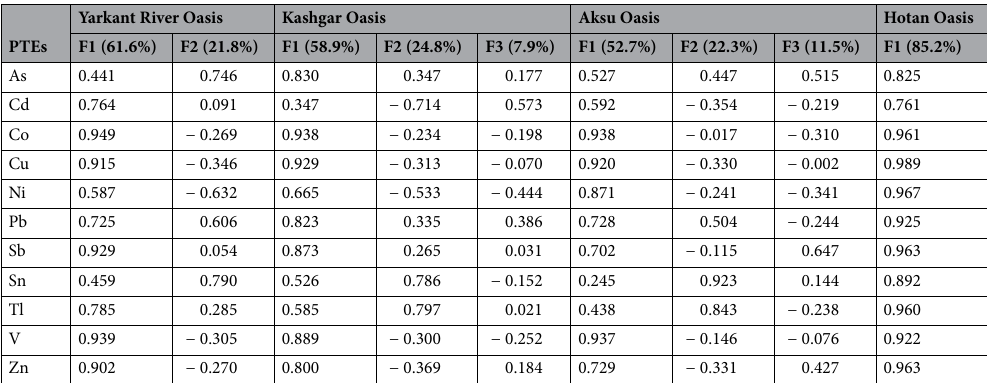
Table 3. Principal component analysis results of PTEs of oasis agricultural soil in the source region of the Tarim River.